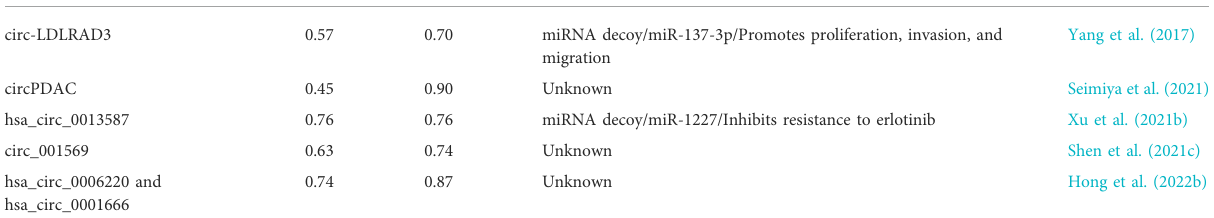
(Table 2). That is, circLDLRAD3, circPDAC, hsa_circ_0013587, and circ_001569 were reported to be